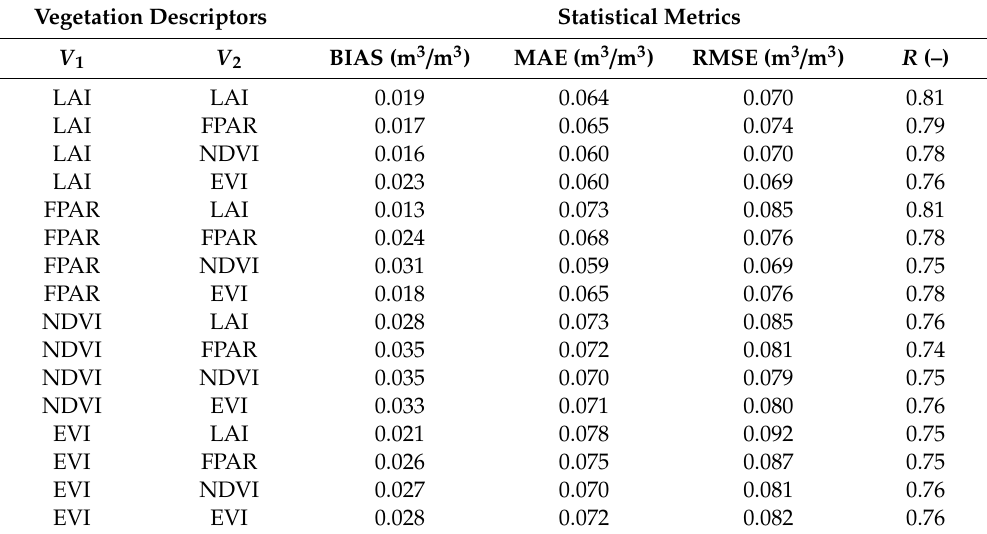
Figure 8. Time series of the measured and estimated soil moisture with the different vegetation combinations used for the coupled model. The “LAI_FPAR” indicates that the V 1 and V 2 are characterized by the LAI and FPAR, respectively. Table 3. Statistical metrics between the measured and retrieved soil moisture.